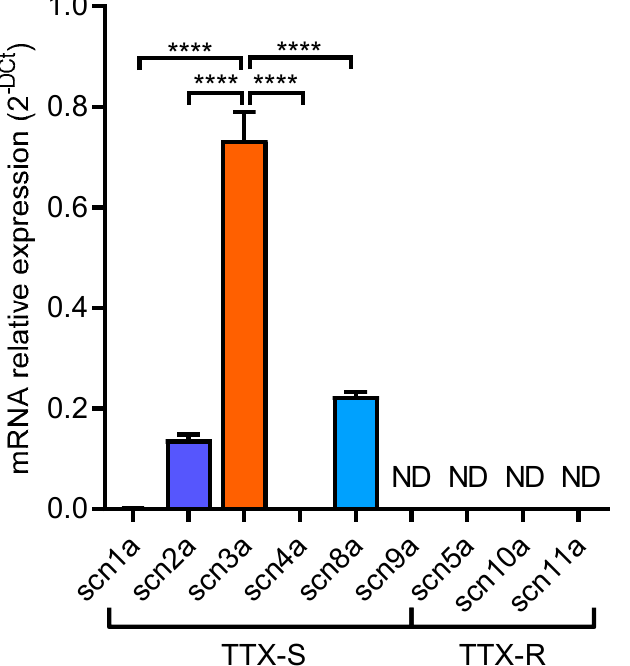
Figure 2. GH3b6 cells express TTX-S Nav channels. Nav channel gene expression profile of GH3b6 cells. The histogram illustrates the expression repertoire of Nav channel genes in GH3b6 cells as established by RT-qPCR. Data are the mean of mRNA relative expression ± SEM ( n = 6). ND: Not Detected. Significance tests between groups of data were performed using one-way ANOVA followed by Bonferroni’s multiple comparison test (**** p < 0.0001).